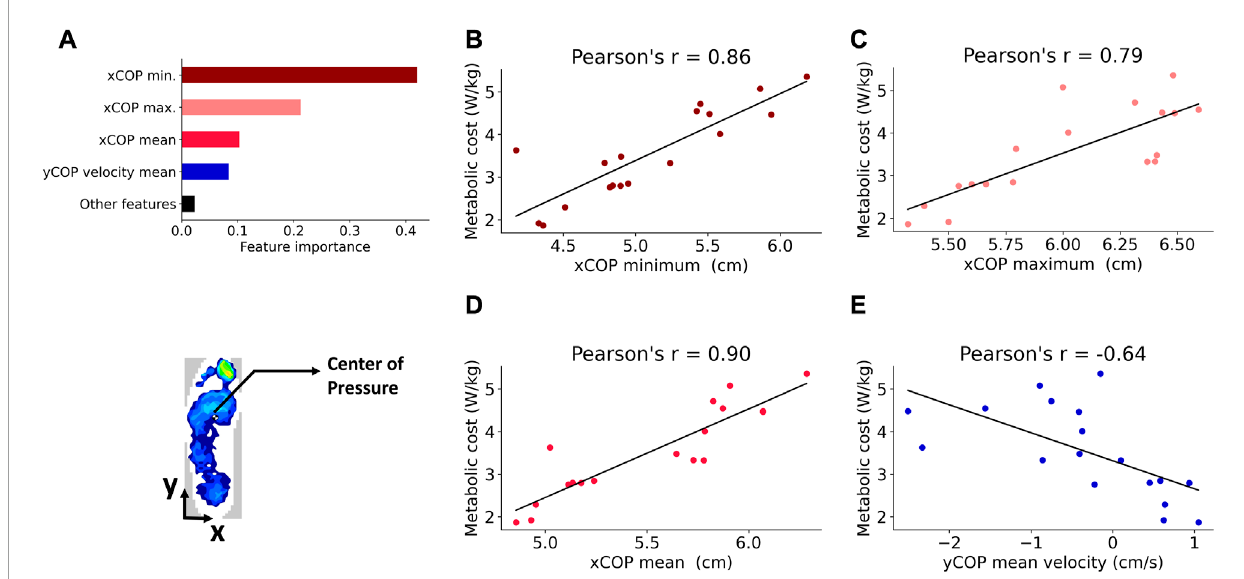
FIGURE 6 (A) Top four important features returned by the random forest: minimum, maximum and mean of the xCoP squat trajectory, and yCoP mean velocity. The importance of the remaining features was below the value indicated by the black bar (B) . Correlation between the xCoP minimum and the metabolic cost (C) . Correlation between the xCoP maximum and metabolic cost (D) . Correlation between the xCoP mean and metabolic cost (E) . Correlation between the yCoP mean velocity and metabolic